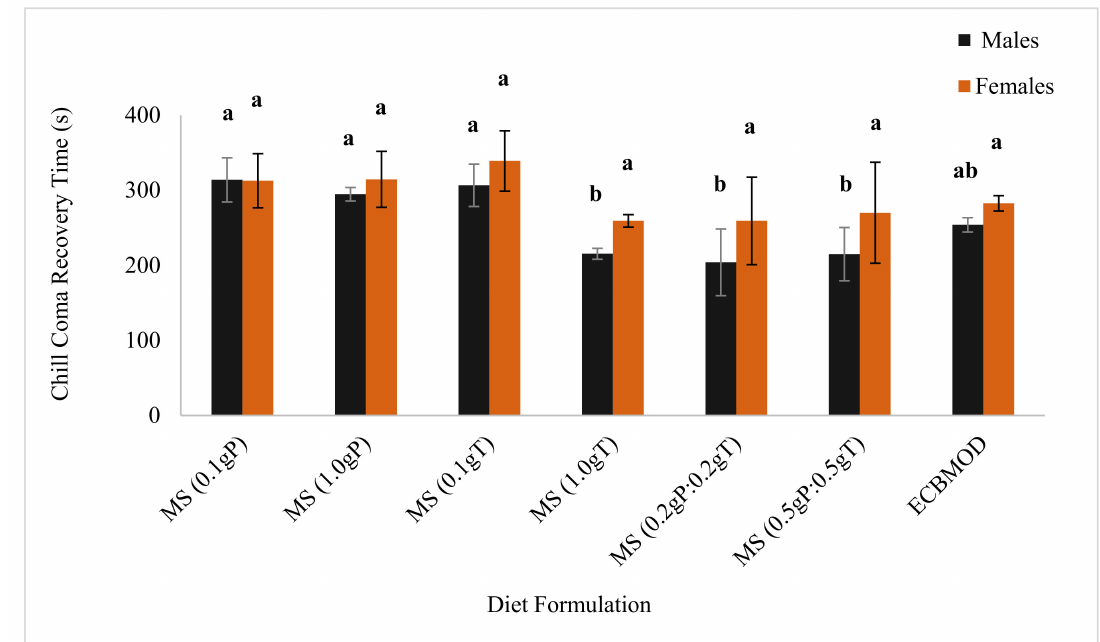
Figure 3. Mean ( ± SE) chill coma recovery time of Eldana saccharina male and female moths [ n = 30] from the MS (0.1 gP), MS (1.0 gP), MS (0.1 gT), MS (1.0 gT), MS (0.2 gP:0.2 gT), MS (0.5 gP:0.5 gT) and ECBMOD control diets. Different lower-case letters above the graph histogram bars indicate that mean differences are significant at the 0.05 level.